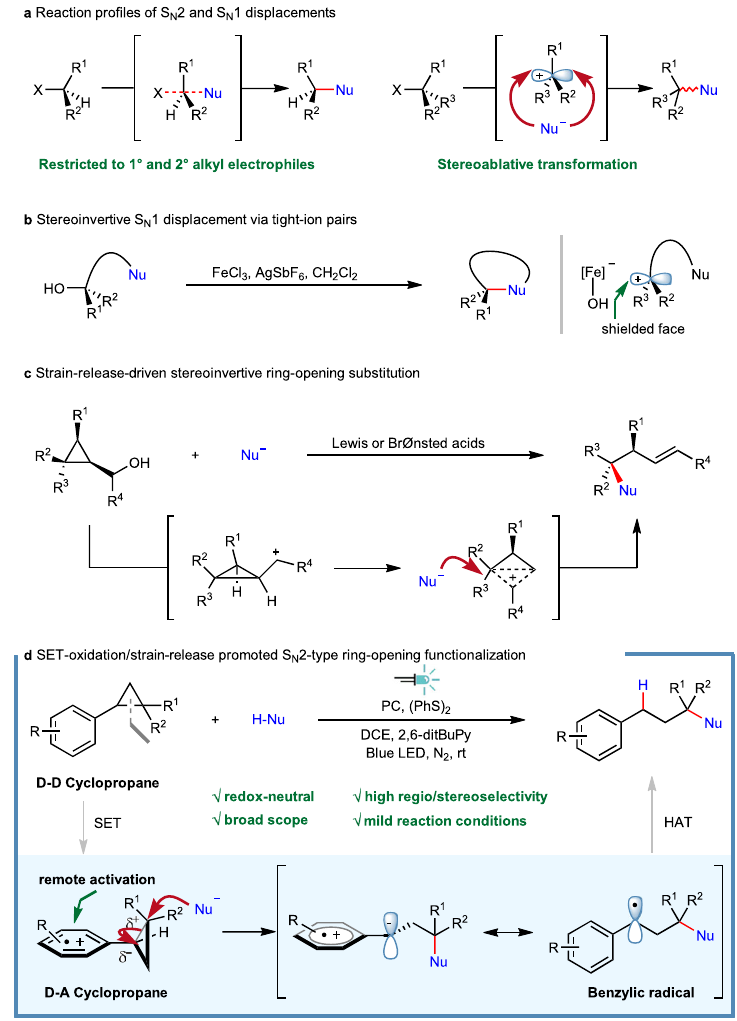
Fig. 1 | Nucleophilic substitution at sterically hindered carbon centers. a Elementary reaction pro fi les of S N 2 and S N 1 reaction. b Iron-catalyzed stereoinvertive intramolecular S N 1 displacement. c Lewis or Brønsted acid catalyzed stereoinvertive ring-opening substitution promoted by strain release. d This